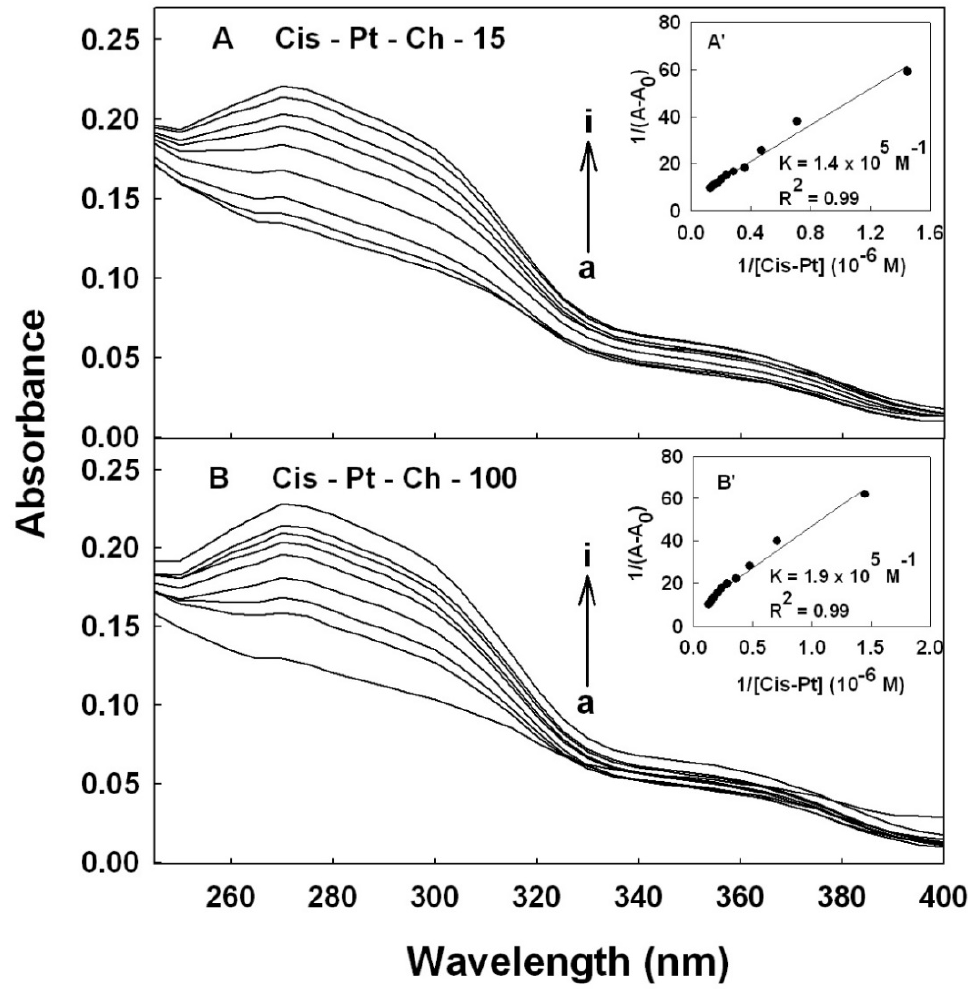
Figure 1. UV–visible spectra of chitosan nanoparticles with cis–Pt with free chitosan at 60 µ M (a) and cis–Pt at 1, 5, 10, 20, 30, 40, 60, and 80 µ M (b–i). Inset: plot of 1/(A 0 − A) vs. (1/drug concentration) and binding constant ( K ) for cis–Pt–polymer complexes. ( A ) Cis–Pt–Ch–15, ( B ) Cis–Pt–Ch–100. Table 1. Variations in the binding constants for Ch–15 and Ch–100 kD with cis–Pt and trans–Pt at different